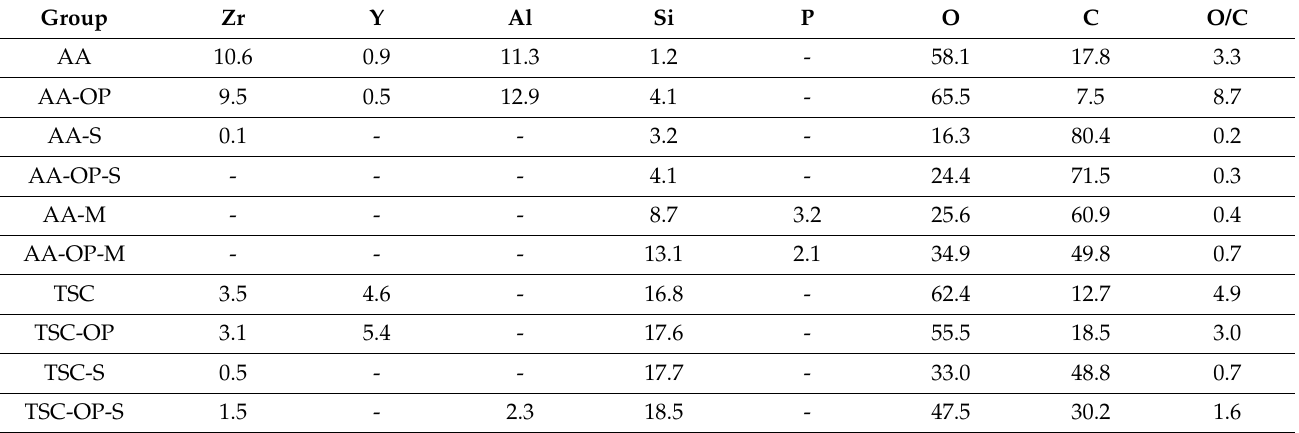
Table 1. XPS analysis revealing the element compositions (%) on the surfaces of the experimental groups.